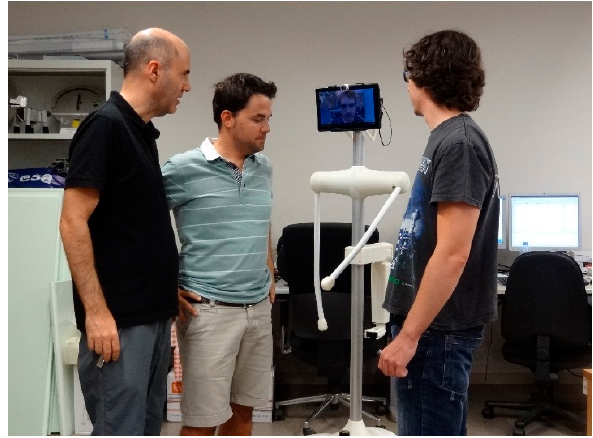
Figure 14. Depiction of the telepresence capabilities of the APR.